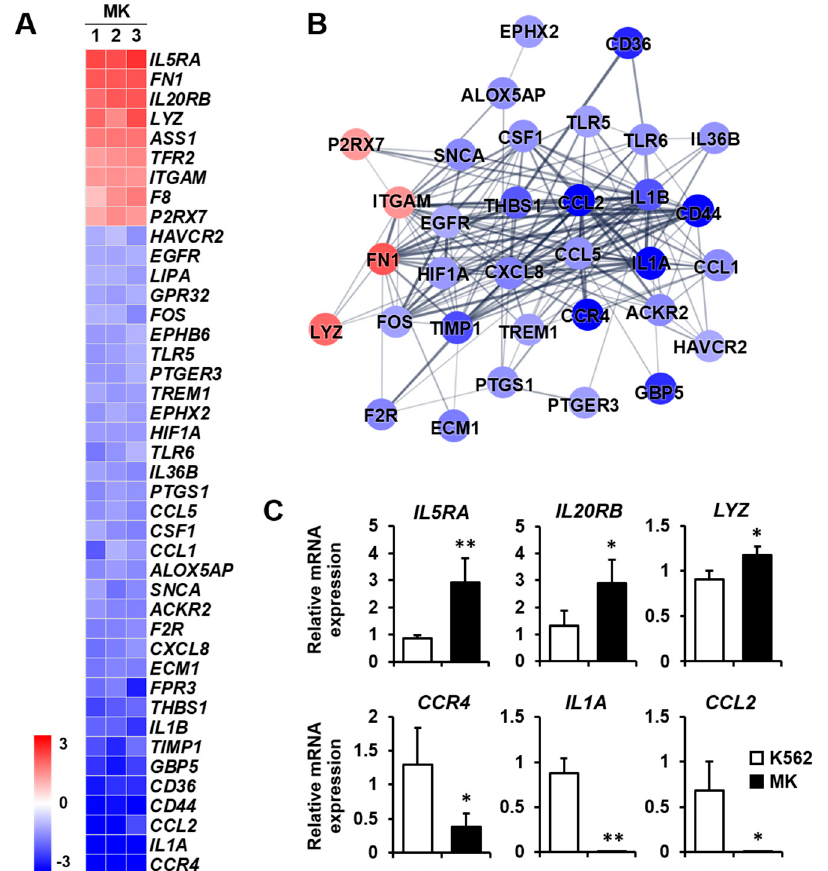
Figure 3. Expression levels by normalized z-scores of genes included in the inflammatory response cluster and the relationship between constituent genes. ( A ) Heat map of genes differentially expressed in megakaryocytes (MK) compared with K562 cells based on the microarray analysis. The red color indicates upregulation and the blue color indicates downregulation. The degrees of colors represent the expression levels of the genes. ( B ) Protein–protein interaction analysis using the STRING database. The red and blue colors denote upregulation and downregulation, respectively. The higher the confidence in the interaction, the greater the line thickness between the proteins. Members without interaction with other genes were excluded from the STRING database analysis. ( C ) Validation of the mRNA expression of selected genes ( IL5RA , IL20RB , LYZ , CCR4 , IL1A , and CCL2 ) differentially expressed in MK by qPCR. Relative expression levels were plotted against gene expression levels in K562 cells. Data are presented as the mean ± standard deviation of three independent experiments. Please see abbreviations for the full names of genes. *, p < 0.05; **, p < 0.01 versus K562 cells.